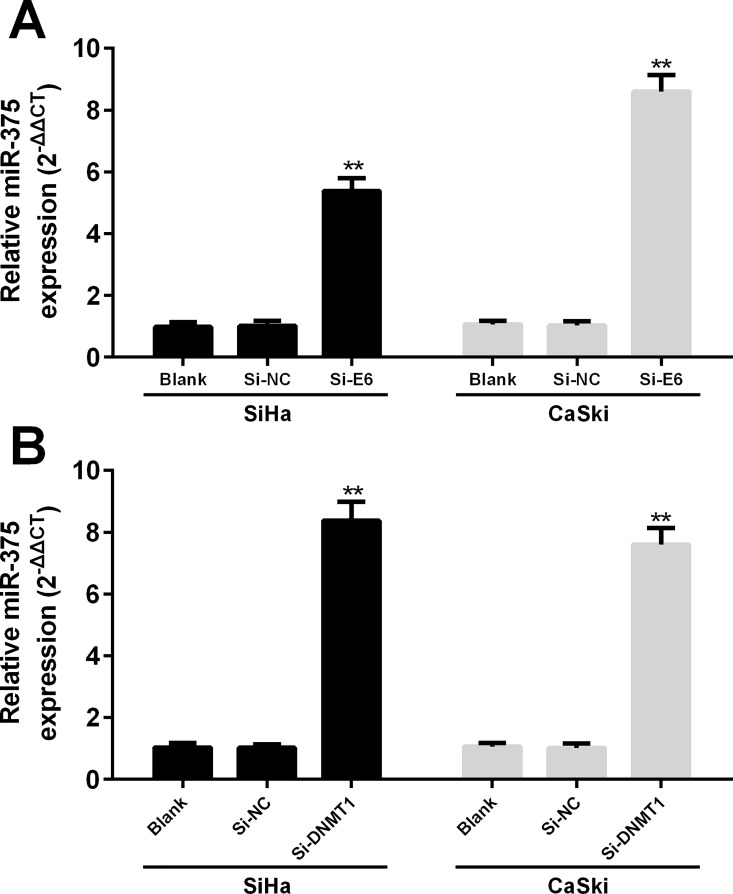
HPV-16 E6 and DNMT1 knockdown increases miR-375 expression in cervical cancer.A-B. QRT-PCR analysis of miR-375 expression in SiHa and CaSki cells after transfection of HPV-16 E6 siRNA (A) or transfected with DNMT1 siRNA (B). **p<0.01.